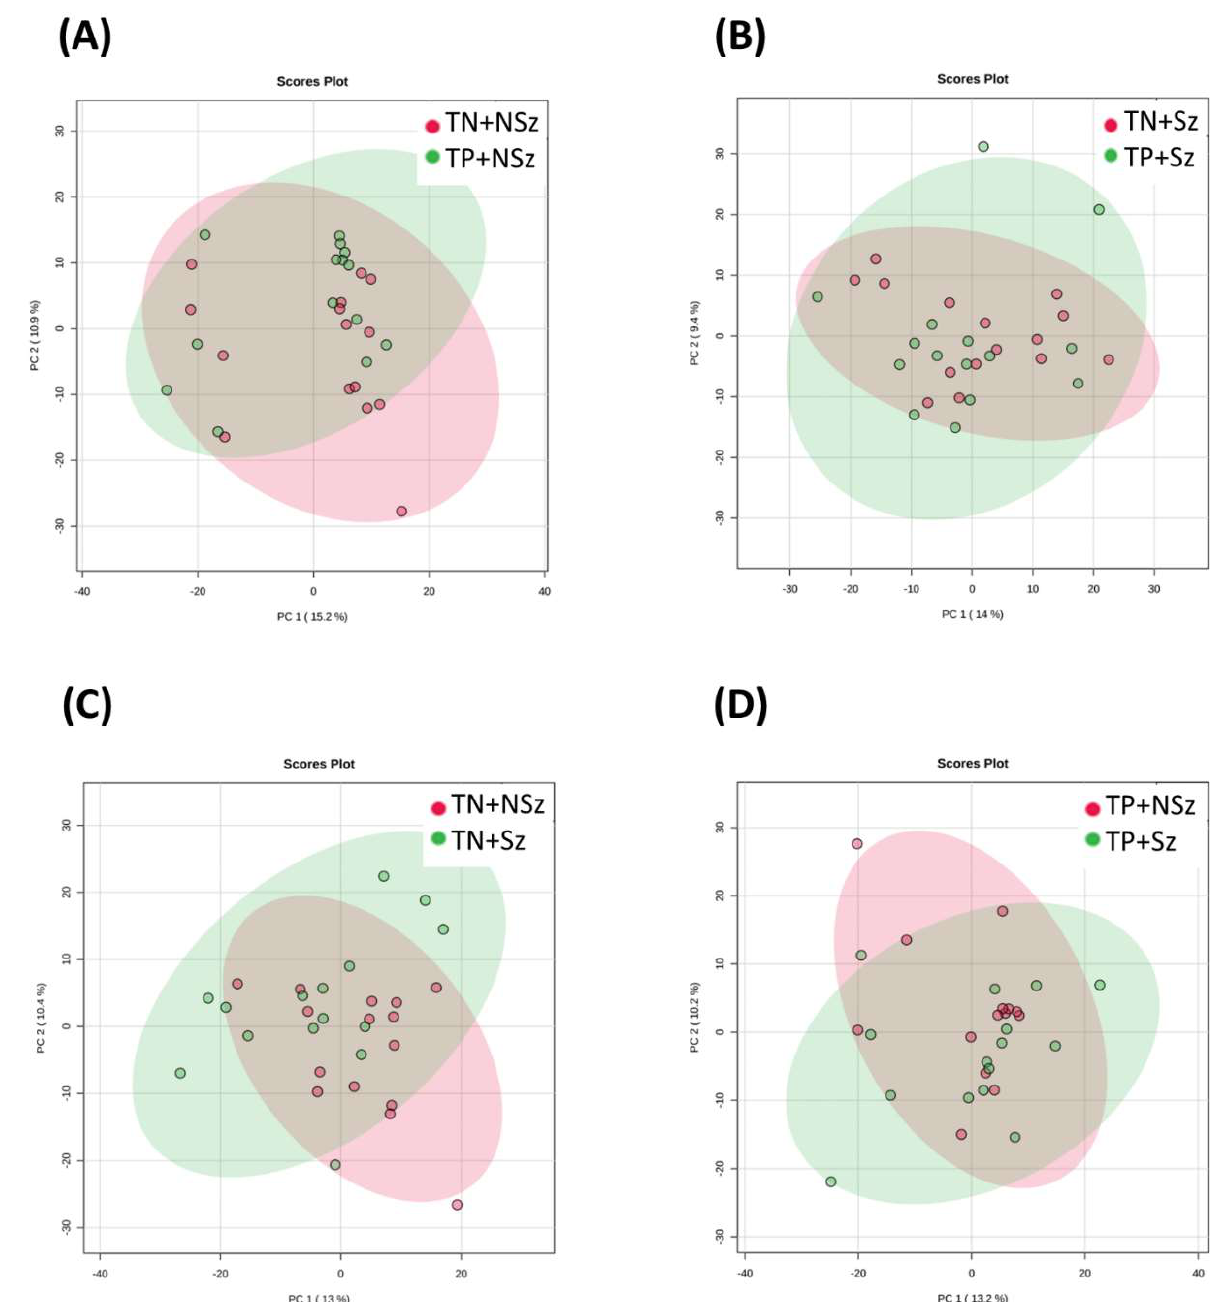
Figure 1. Distribution of the plasma samples from positive mode in PCA score plots for differ- ent group comparisons. Comparisons were made for ( A ) TP+NSz vs. TN+NSz, ( B ) TP+Sz vs. TN+Sz, ( C ) TN+Sz vs. TN+NSz and ( D ) TP+Sz vs. TP+NSz. TP+NSz: non-schizophrenia sub- jects with Toxoplasma infection; TN+NSz: non-schizophrenia subjects without Toxoplasma infec- tion; TP+Sz: schizophrenia subjects with Toxoplasma infection; TN+Sz: schizophrenia subjects with Toxoplasma